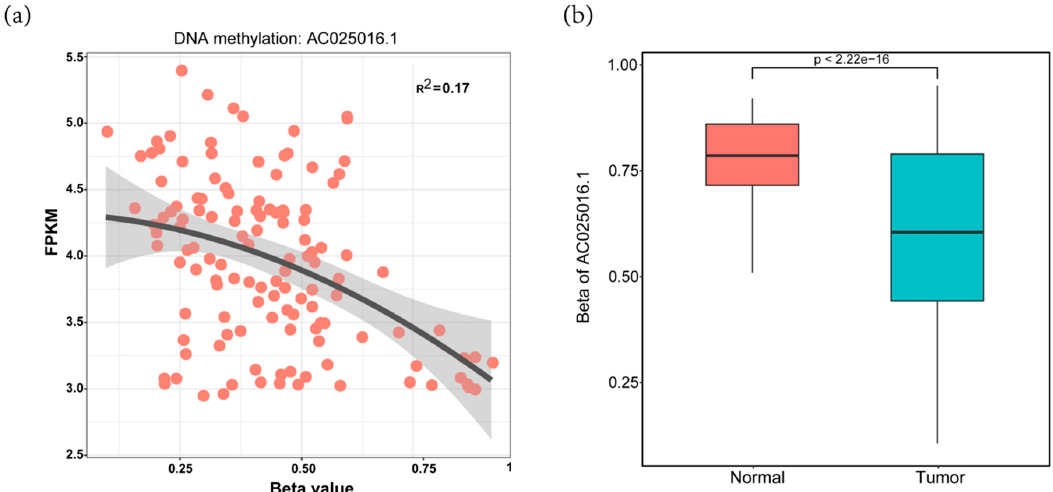
Figure 5. Example of a lncRNA driven by DNA methylation. ( a ) the AC025016.1 expression level (FPKM) was inversely correlated with its promoter methylation level ( β value); ( b ) Boxplot showing that the β values of primary tumor samples were significantly higher than those of normal tissue samples.